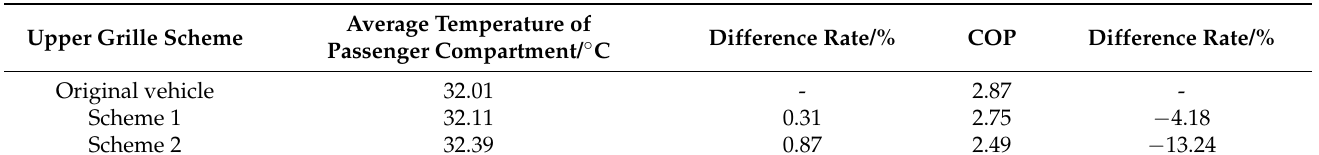
Table 6. Comparisons of air conditioning performance parameters and difference rate under differ- ent schemes.